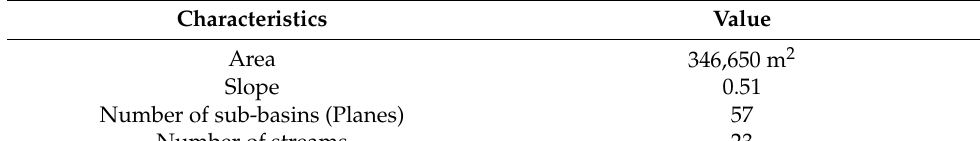
Table 3. Detail value of study basin [3].